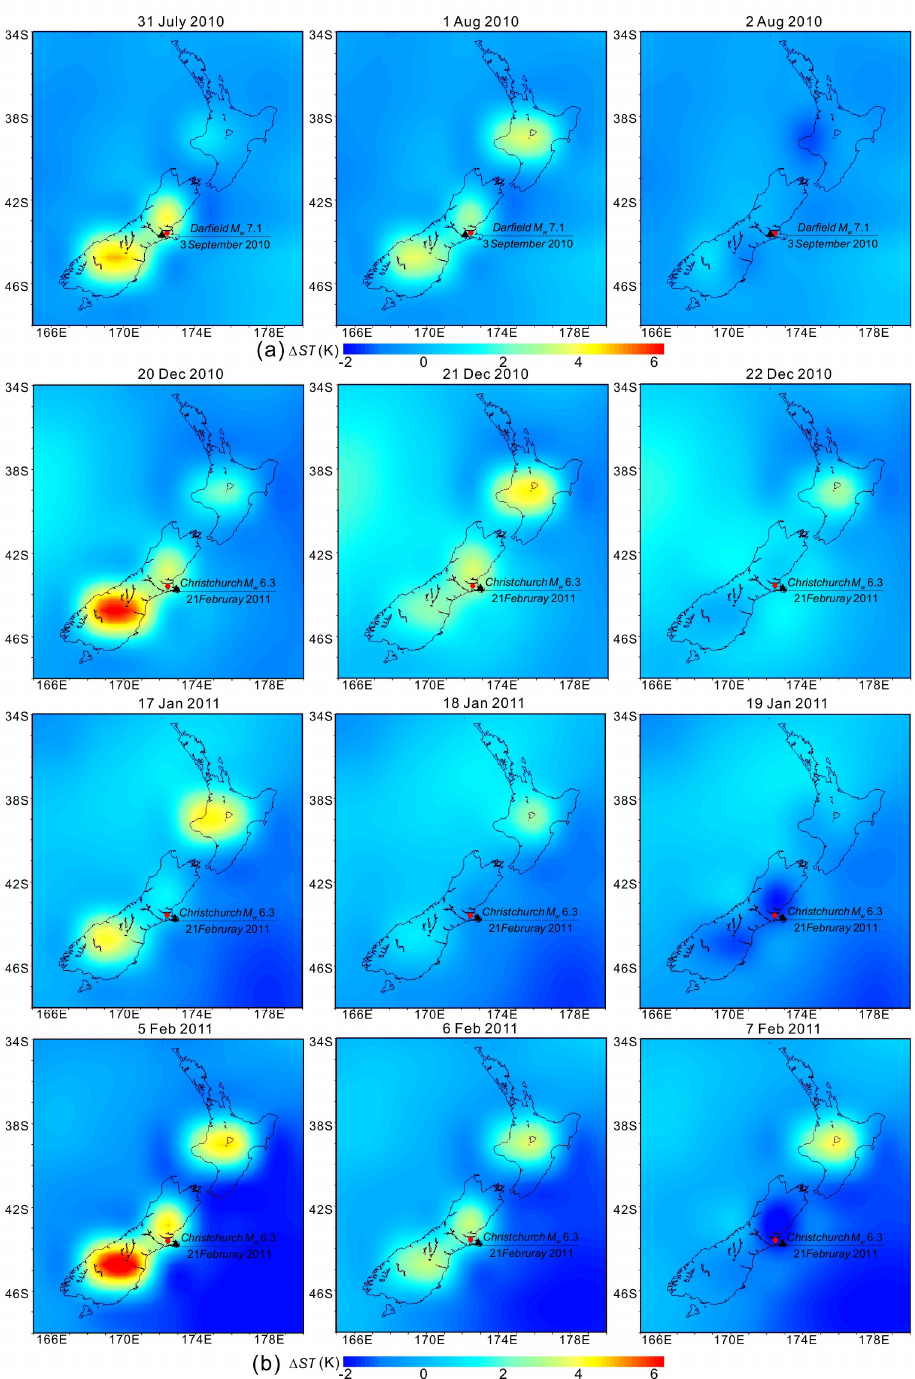
Fig. 4. (a) Spatial distribution of surface temperature increment ( 1 ST ) from 31 July to 2 August 2010, obtained by subtracting the mean value of years without large ( M > 5 . 5) earthquakes (1980–2009), representing a background, from the data of 2010; (b) Spatial distribution of surface temperature increment ( 1 ST ) on 20–22 December 2010, 17–19 January 2011 and 5–7 February 2011, respectively, obtained by subtracting the mean value of years without large ( M > 5 . 5) earthquakes (1980–2009 or 1981–2010), representing a background, from the data of 2010 and 2011. The black triangles in (a) and (b) indicate the epicenter of the mainshock and the 21 February 2011 aftershock, respectively. The red points indicate the weather station